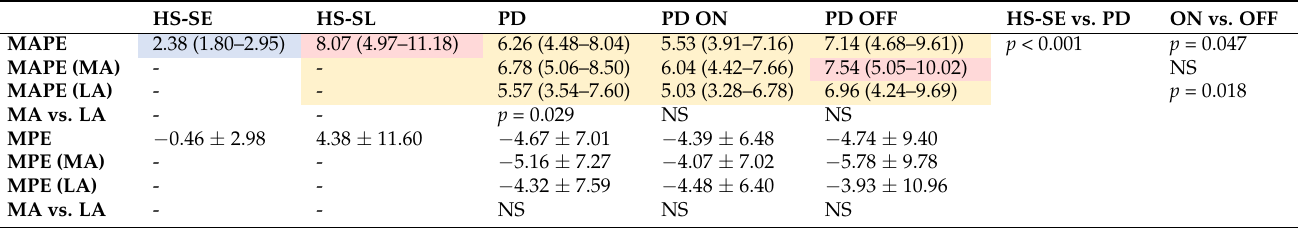
Table 3. MAPE and MPE between the number of steps recorded by GV4 and manual counting. Variables are reported as mean (CI 95%) for MAPE and mean ± SD for MPE. In HS, data are reported for self-selected speed and slow speed. In PD patients, data are reported for the overall population, in ON, in OFF, and for the most- and least-affected sides. HS-SE: Healthy subjects at self-selected speed; HS-SL: Healthy subjects at slow speed; LA: Least-affected side; MA: Most-affected side; MAPE: Mean absolute percentage error; MPE: Mean percentage error; PD: Parkinson’s